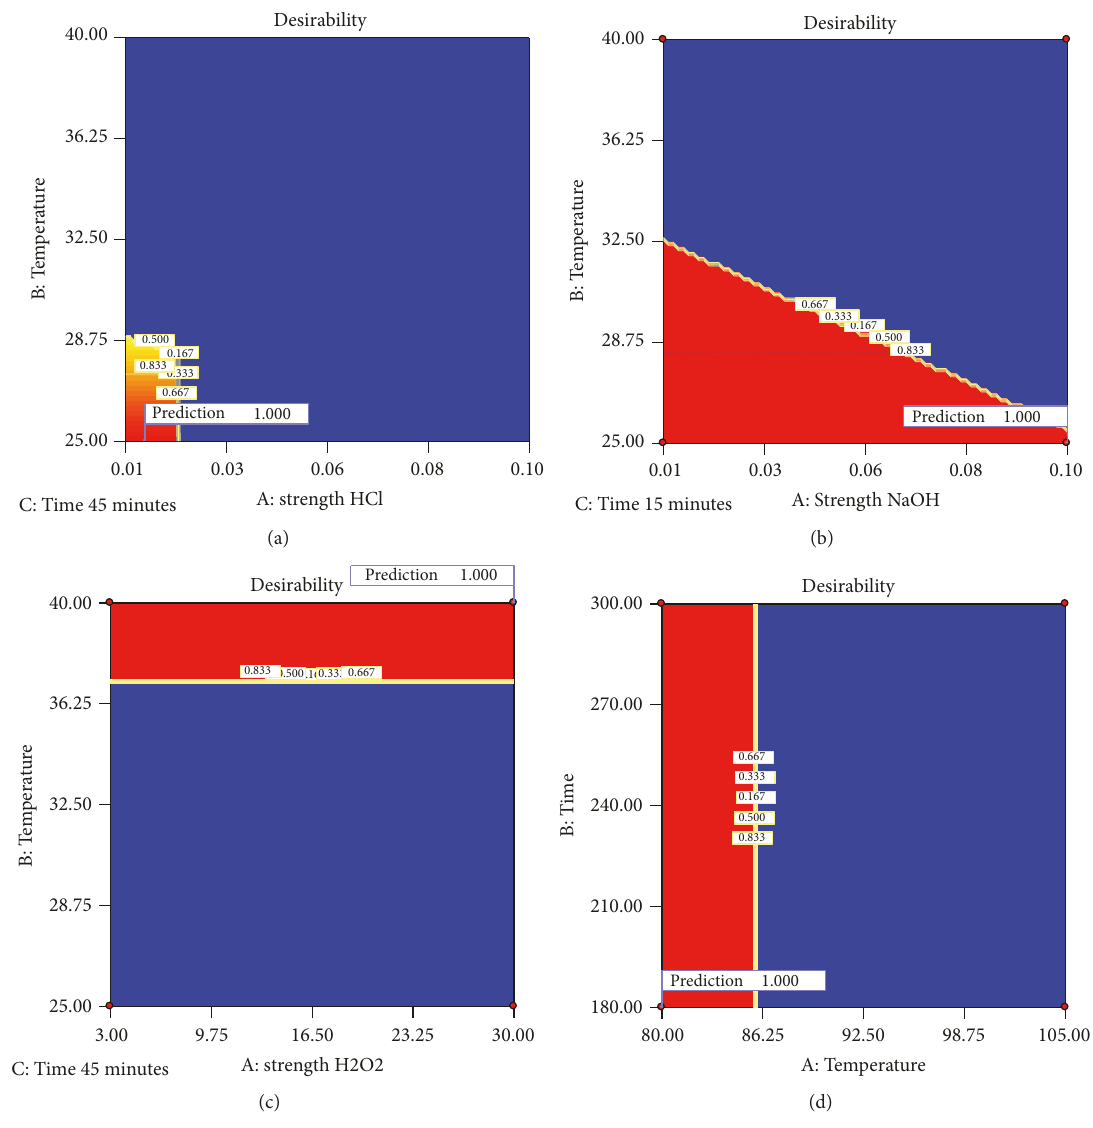
Figure 6: Optimization of the selected responses by means of the desirability function. The red area corresponds to the optimum conditions while time maintained constant: (a) acid degradation; (b) alkali degradation; (c) oxidative degradation; and (d) thermal